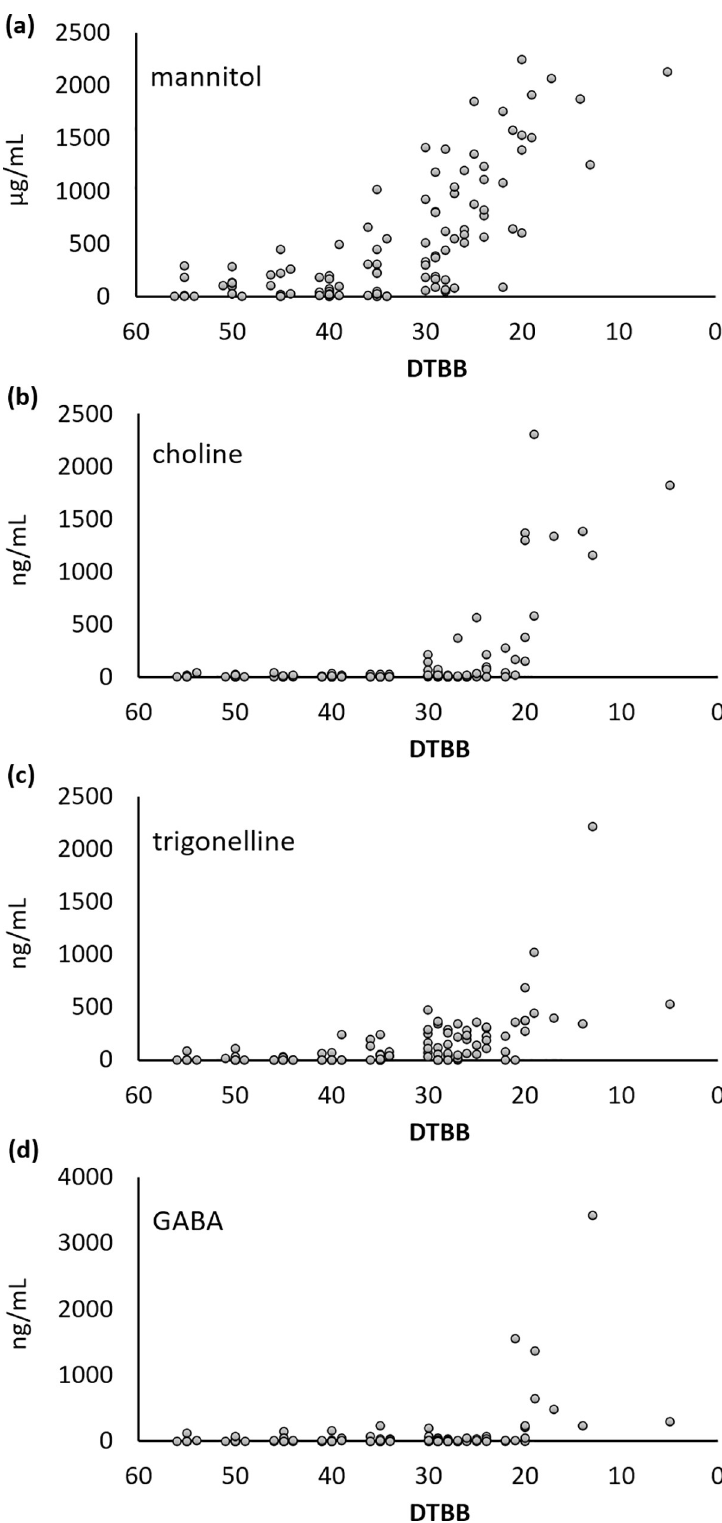
Fig 10. Concentrations of (a) mannitol, (b) choline, (c) trigonelline and (d) GABA in sap samples across the production season. Mannitol showed a site dependent gradual increase, while choline, trigonelline and GABA showed a sudden increase in the late